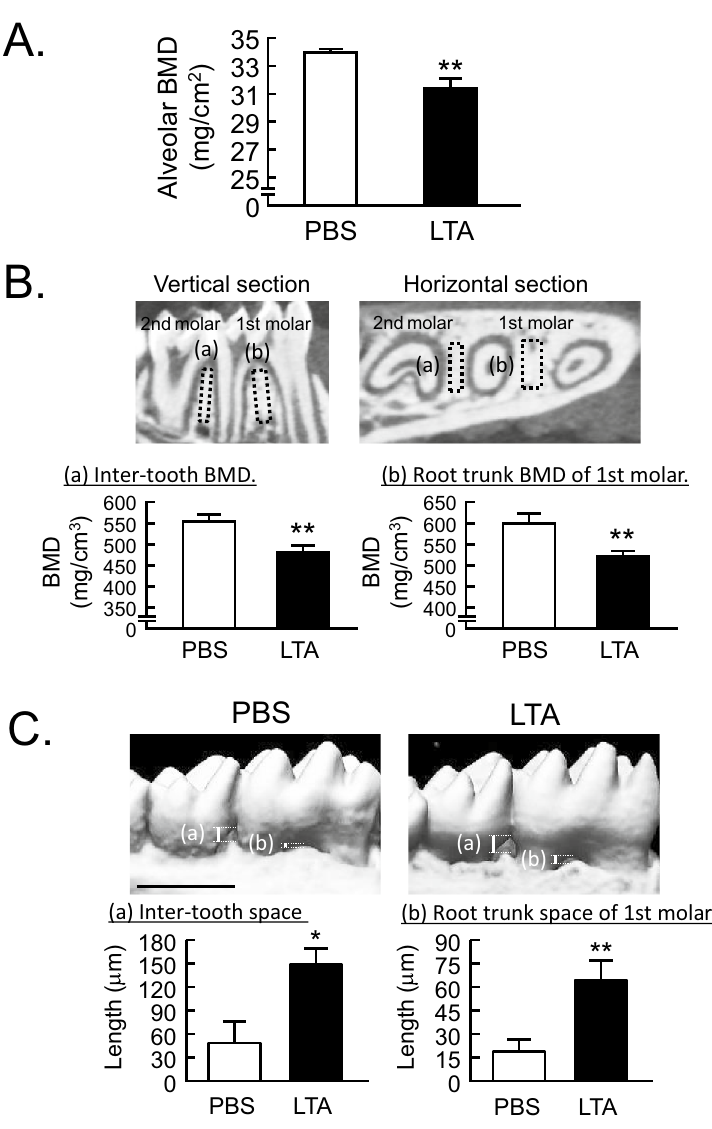
Figure 6. LTA induced bone resorption in an in vivo mouse experimental model of periodontitis. ( A ) The BMD of alveolar bone was measured using DXA. ( B ) The BMD of alveolar bone was calculated by an analysis of 3D-μCT imaging. The black dotted square indicates the analyzed area of the vertical and horizontal sections shown in the upper images. The BMD of the alveolar bone was measured in the inter-tooth areas of the 1st and 2nd molars (a), and at the root trunk of the 1st molar (b). Both areas showed a decreased bone mass, which reflected increased bone resorption by LTA. ( C ) The loss of vertical alveolar bone was analyzed by 3D-μCT imaging. The length of the vertical white line in the upper μCT images (a) indicates the length of alveolar bone loss from the gingival sulcus to the alveolar bone (inter-tooth space) and (b) indicates the bottom of the molar root trunk to the alveolar bone (root trunk space) of the 1st molar. The length reflected alveolar bone loss. Scale bar: 1 mm. The data are expressed as the mean ± SEM of 6 mice. A significant difference between the two groups was indicated; * P < 0.05 and ** P < 0.01 versus control; by Student’s